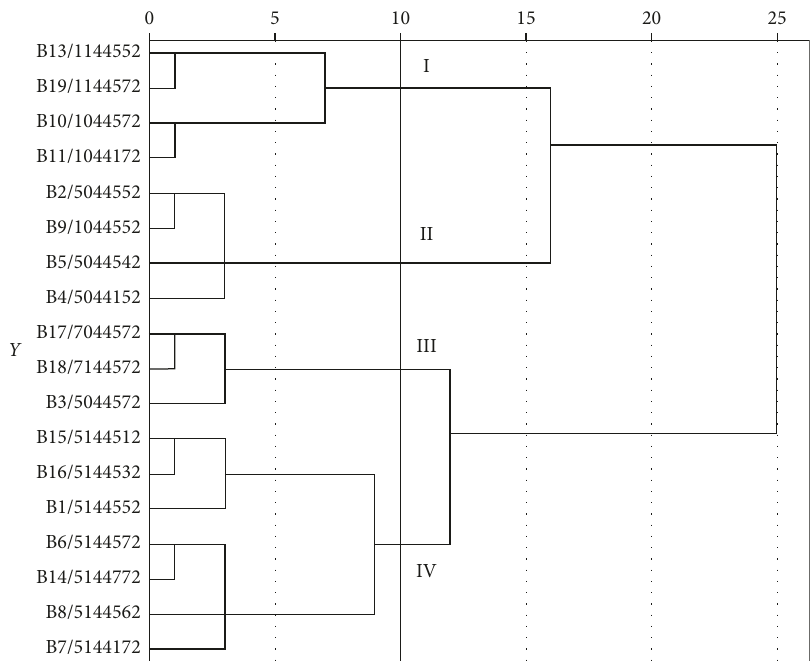
Figure 3: Dendrogram revealing the relationship between human and water biotypes.